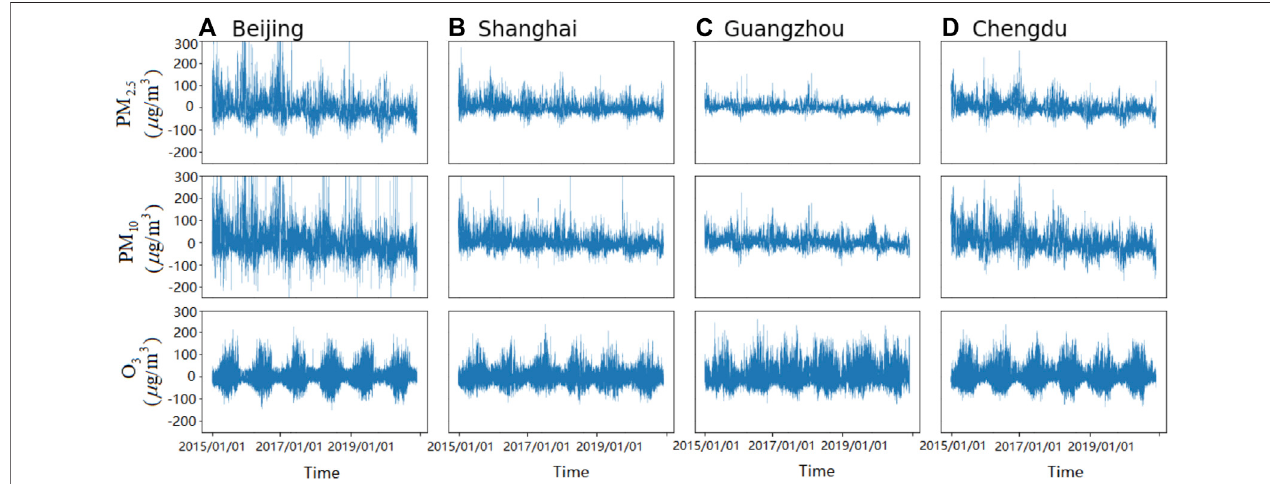
FIGURE 2 | (color online) Spatial distributions of the autoregression parameter a for AR (1) process for (A) PM 2.5 , (C) PM 10 and (E) O 3 in summer. (B) , (D), and (F) are same as (A) , (C) , and (D) but in winter.